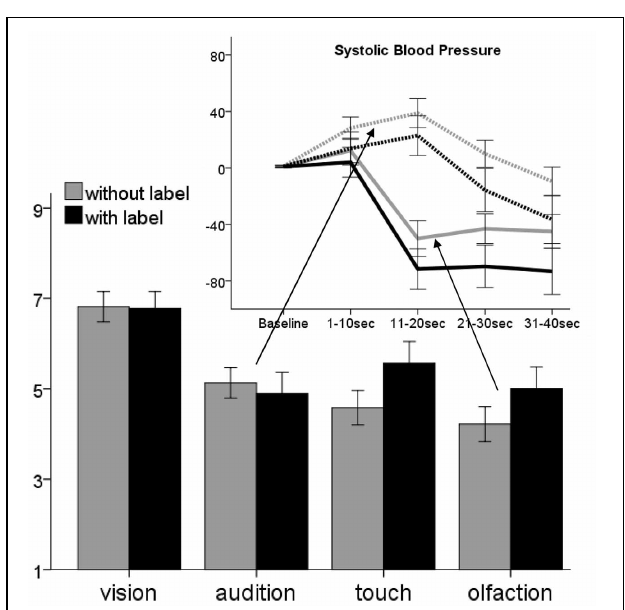
Note: Only participants’ response for stimuli presented unlabeled are presented in order to avoid possible label influences. Error bars indicate 95% confidence interval.